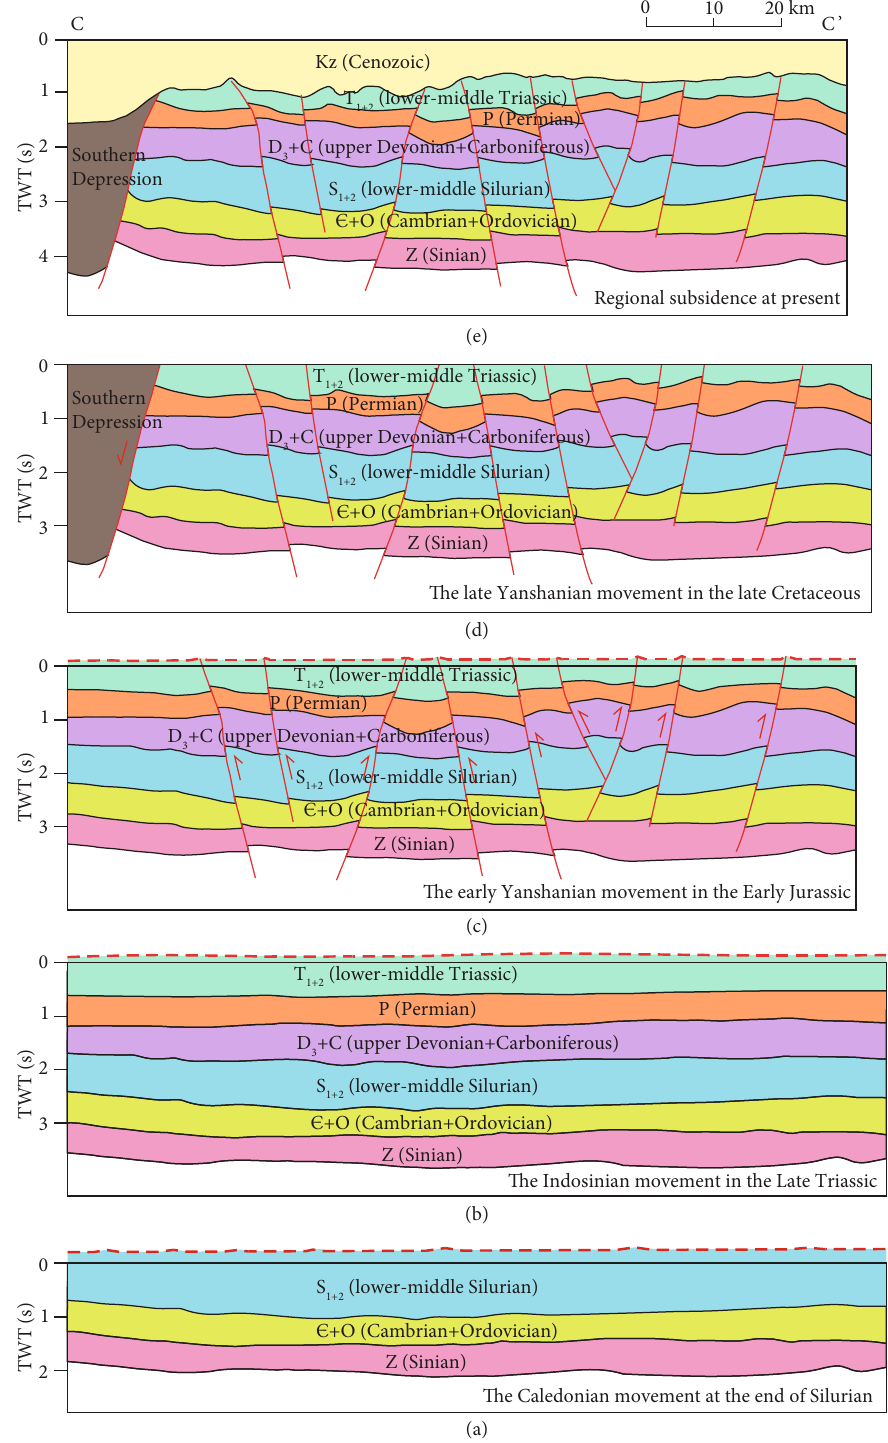
Figure 3: NW-SE-trending tectonic evolution section of the Wunansha Uplift, South Yellow Sea basin (see Figure 1 for pro fi le